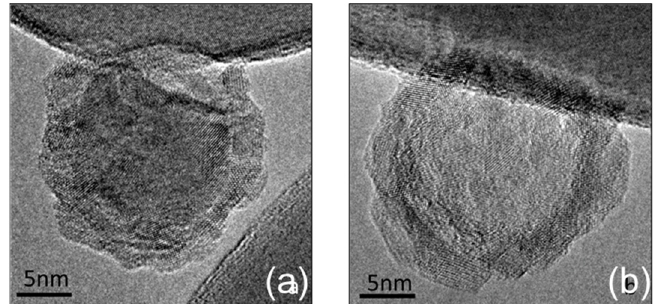
Figure 10. ( a ) Partial void/shell structure areas of deactivated materials show cleavages in between TiO 2 and Ni metal. ( b ) Void/shell structures after 50% deactivation. Reproduced with permission from Ref. [64]. ( a , b ) Copyright 2015, American Chemistry